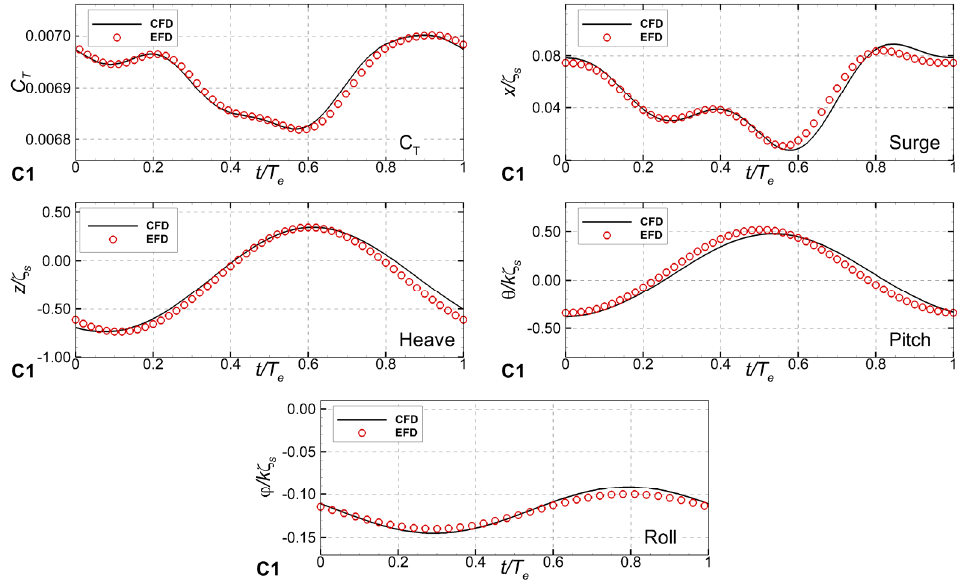
Figure 12. Comparisons between the time histories of the reconstructed resistance coefficient ( C T ) , surge ( x ) , heave ( z ) , roll ( ϕ ) , and pitch ( θ ) measured (EFD) [33] and computed (CFD) over a period of the encounter wave in the FRxz ϕθ head waves scenario.